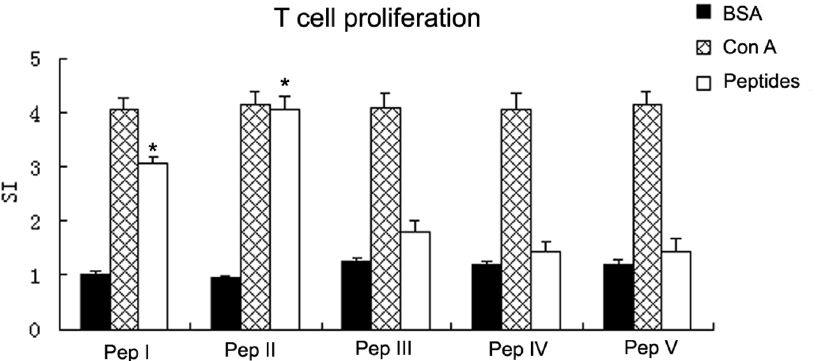
Figure 1. T cell activation in mice following immunization. Splenocytes were isolated from mice 2 weeks after booster immunization and were stimulated in vitro with peptides I–V as specific antigens. T cell proliferation was determined by the MTT method. Results are shown as the stimulation intensity (SI). *Significantly different from the BSA control group.